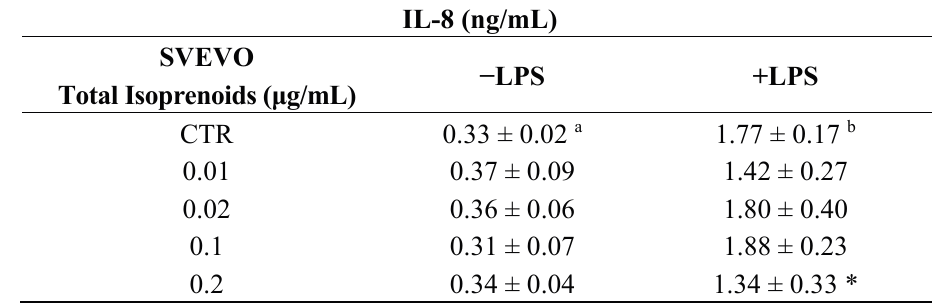
Table 2. Basal ( − LPS) and stimulated (+LPS) IL-8 secretion levels produced by HT-29 human intestinal cell line treated with different isoprenoids concentrations from Svevo extract. Different letters indicate significant differences between compounds ( n = 12, p < 0.05). The comparison is between isoprenoids treatments vs. vehicle control (CTR) ± LPS ( n = 12, * p <